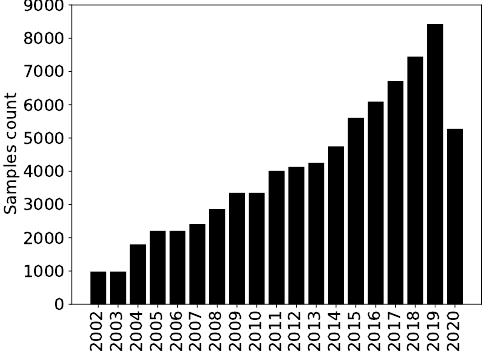
Figure 2. Time evolution of the number of samples in the Refinitiv ESG dataset. Refinitiv ESG data includes samples from different regions of the world. Each region focuses on the European region and includes all the companies in the Refinitiv ESG dataset whose country of incorporation is in Europe or in a European-dependent